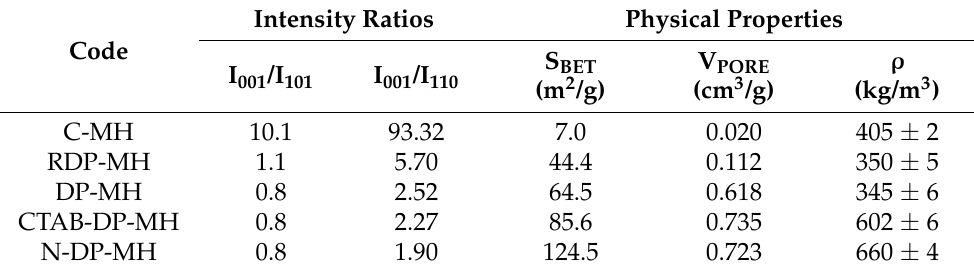
Table 2. Structural and morphological properties of the investigated samples.